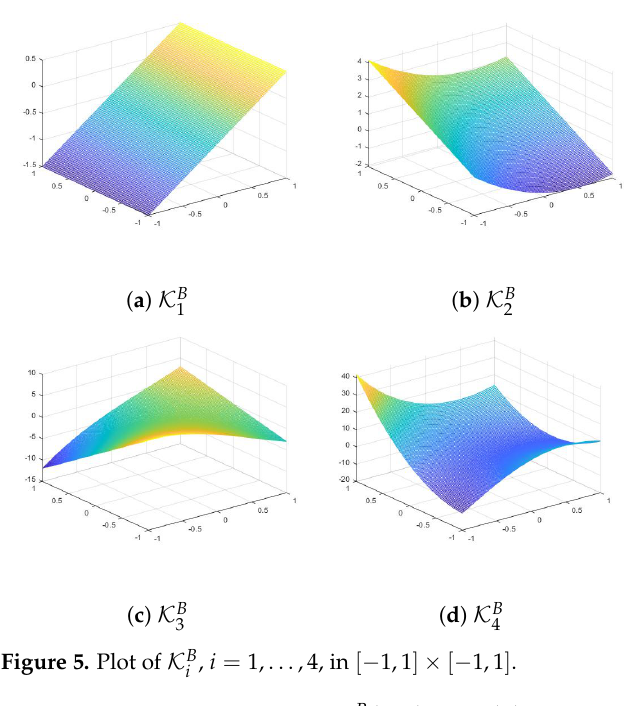
, i = 1, . . . ,4, in [ − 1,1 ] × [ − 1,1 ] i